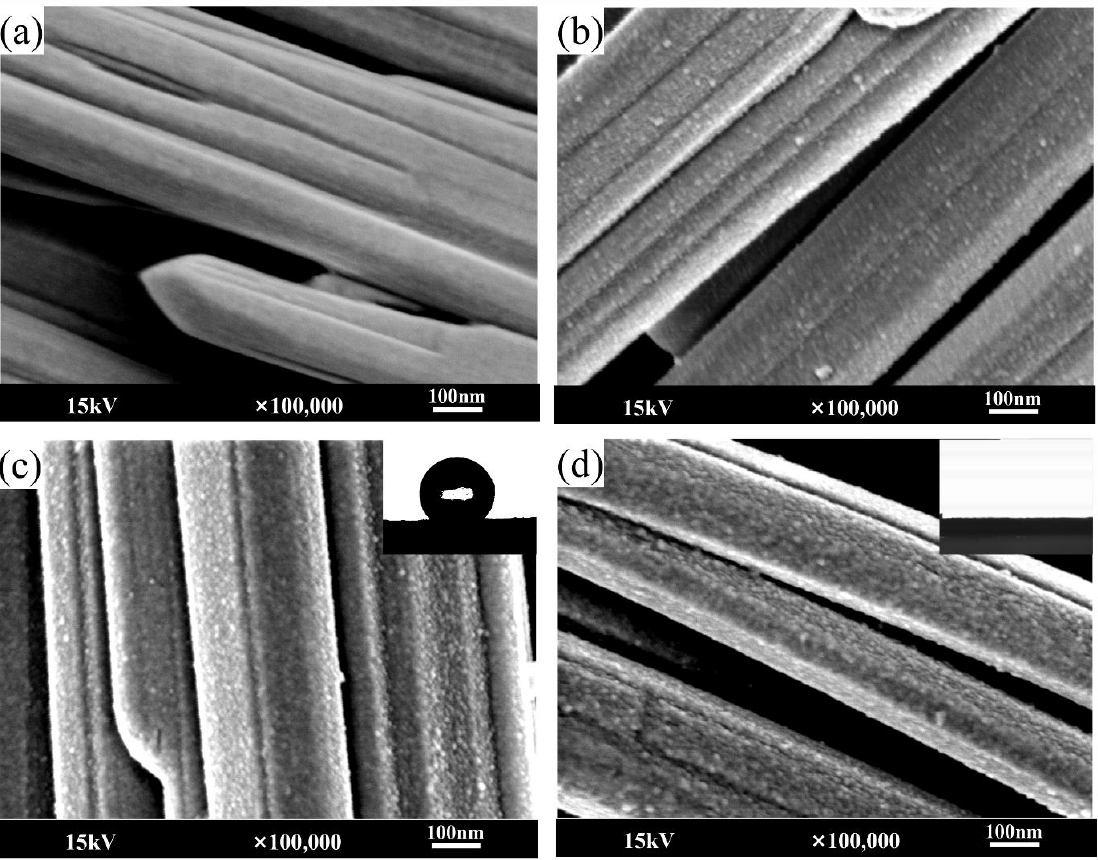
Figure 5 Images and SEM micrographs of ( a ) Unmodified MOSw, ( b ) MOSw@SiO 2 , ( c ) Figure 5. Images and SEM micrographs of ( a ) Unmodified MOSw, ( b ) MOSw@SiO 2 , MOSw@SiO 2 @KH570, ( d ) MOSw@SiO 2 @PDA. ( c ) MOSw@SiO 2 @KH570, ( d ) MOSw@SiO 2